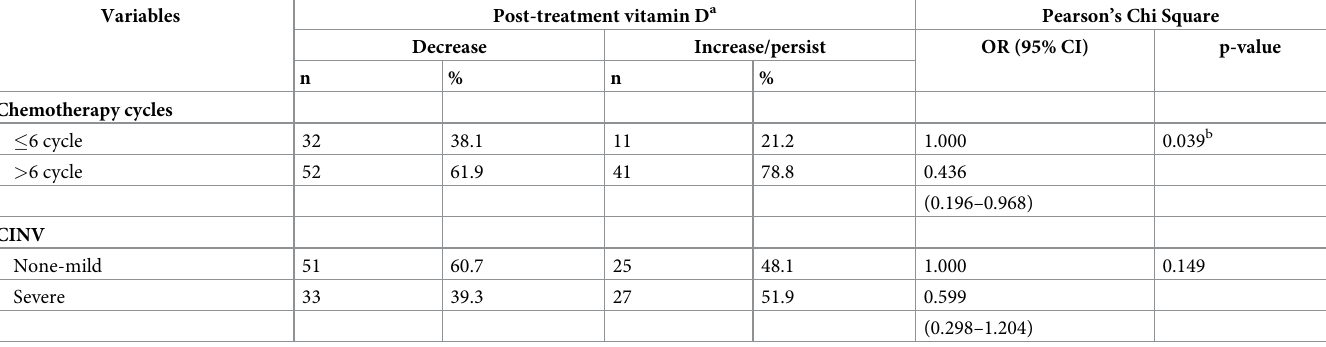
Table 4. Association of chemotherapy cycles and nausea and vomiting with the decrease of post-treatment vitamin D concentration (n = 136).